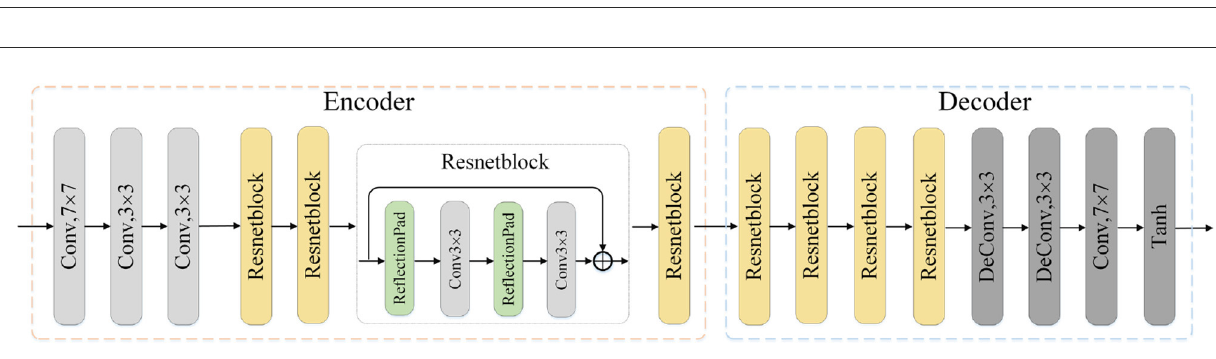
FIGURE2 Illustration of one translation module architecture. The input is the image x of source or target domain and the output is the translated image. Conv: convolution layer, Deconv: deconvolution layer, Tanh: Hyperbolic